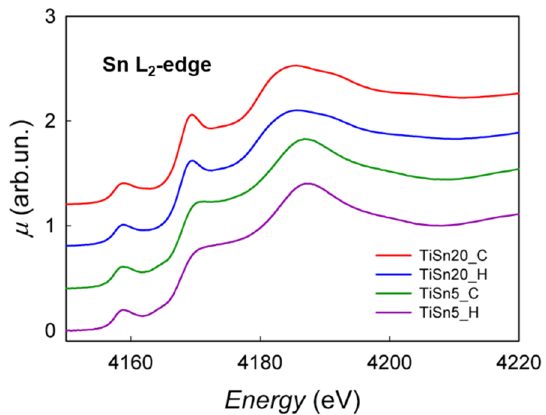
Figure 4. XAS spectra at the Sn L 2 -edge of TiSn20_C, TiSn20_H, TiSn5_C, and TiSn5_H.